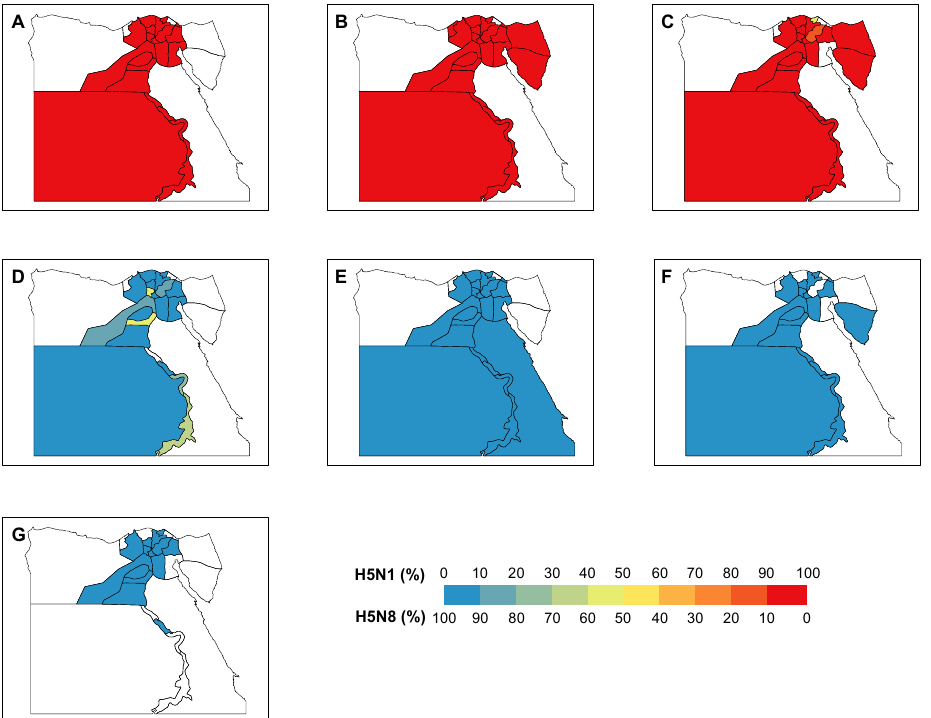
Figure 3. Distribution of H5N1 and H5N8 positive samples in Egypt. The proportions of positive sample of each subtype are shown by governorate in each year during ( A – G ) 2014–2020.